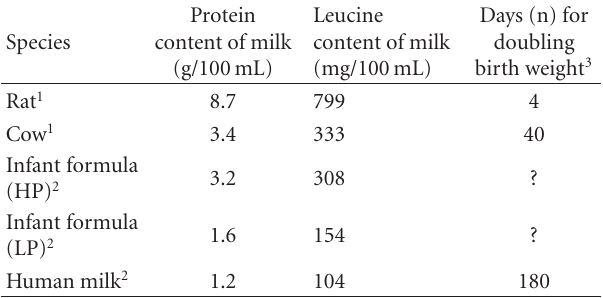
Table 1: Leucine content of mammalian milk and growth rate.